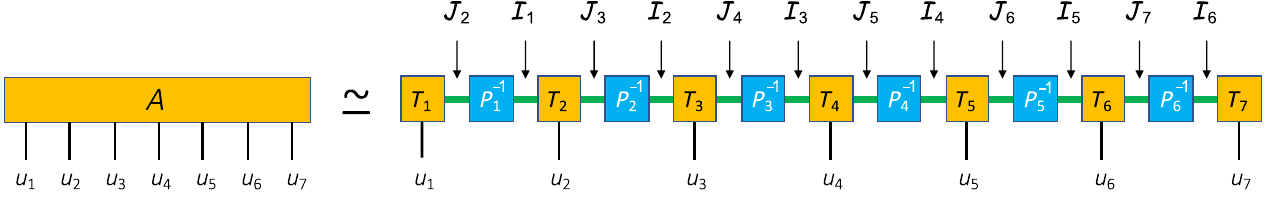
FIG. 4. Pictorial representation of TCI formula for A defined in Eq. (16). The T α tensors and P − 1 α pivot matrices are represented by orange and blue squares, respectively. The green lines correspond to contracted discrete indices I α or J α , as indicated by the arrows. The thin black lines correspond to the variables u α